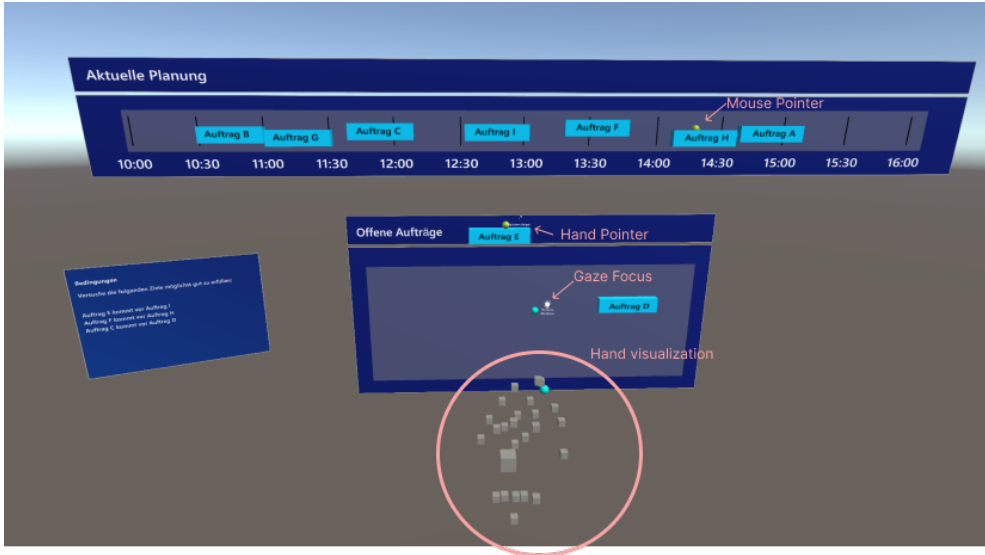
Figure 7. View of the collaborative application from the perspective of the desktop